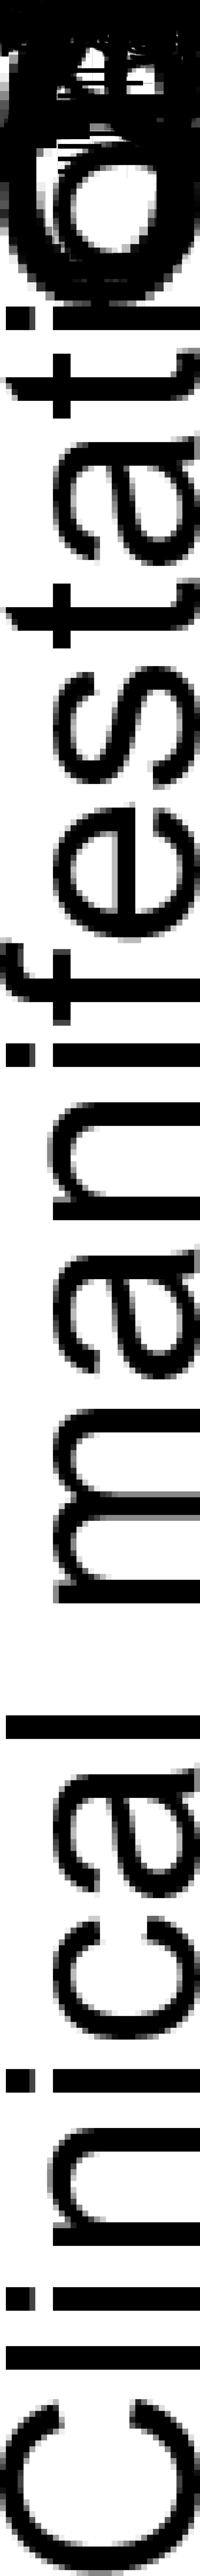
Time since symptom onset (with respective standard deviations).